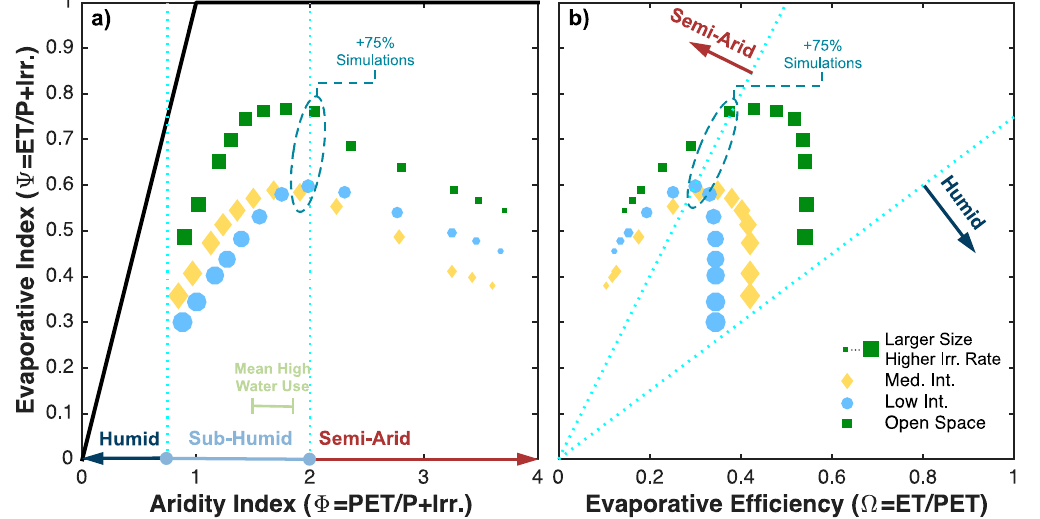
Figure 7. Budyko and water–energy plots for simulations. Full study period mean modified ( a ) aridity index vs. evaporative index and ( b ) evaporative efficiency vs. evaporative index for each irrigation volume (mean of all irrigation timings). Irrigation volume is represented by size of symbol and the “mean” high water use area volumes (middle 50% of high irrigation rates for domain and time period) are shown in ( a ). Black lines in ( a ) are the theoretical water and energy limits and the dotted blue lines are transition points in aridity [85,86].